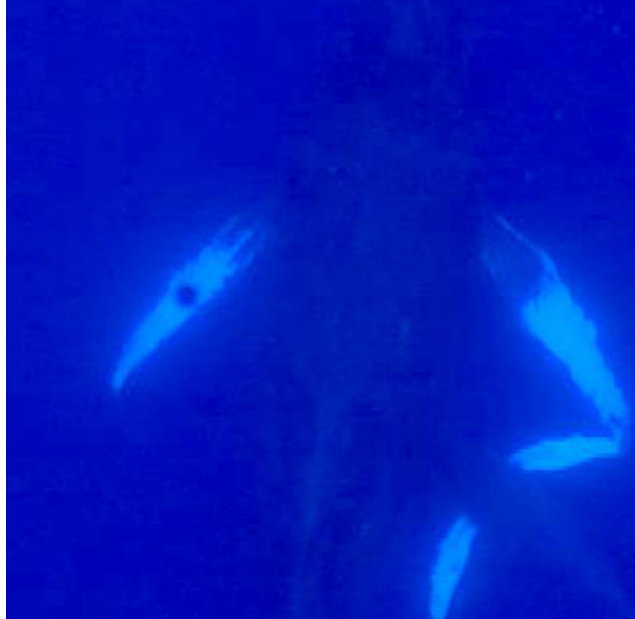
Figure 3. Focal Group 3 where calf approached and again positioned on right side, remaining in the suckling position for duration of 15 s. Both mother and calf sculling with pectoral fins to maintain positioning.